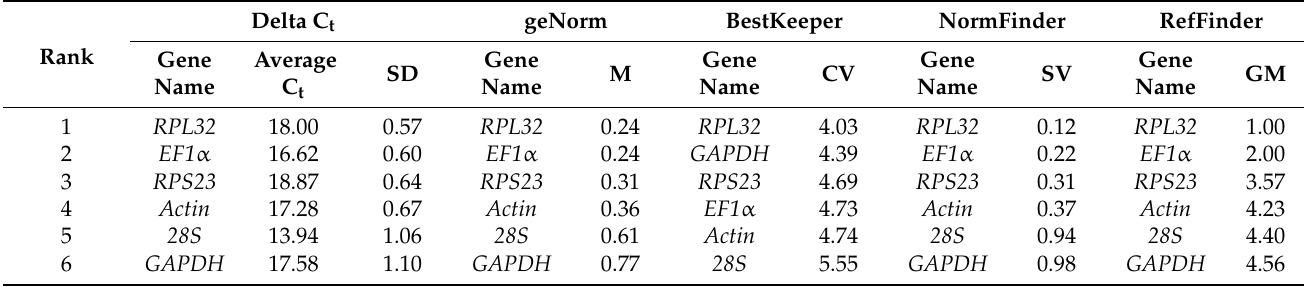
Figure 1. C t value distribution of candidate reference genes in all examined samples from B. germanica ( A ) or P. americana ( B ) . The median and quartiles are indicated by dashed and solid lines. Table 1. Expression variation and stability ranking of the candidate reference genes using geNorm, BestKeeper, NormFinder, and the comprehensive RefFinder algorithm in B. germanica .